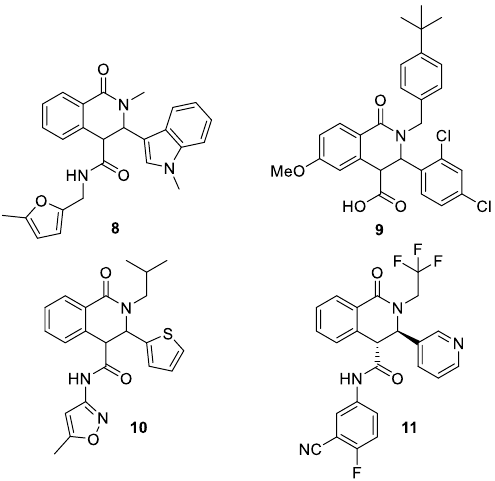
Figure 2: Examples of diversely biologically active tetrahydroisoquinolones.